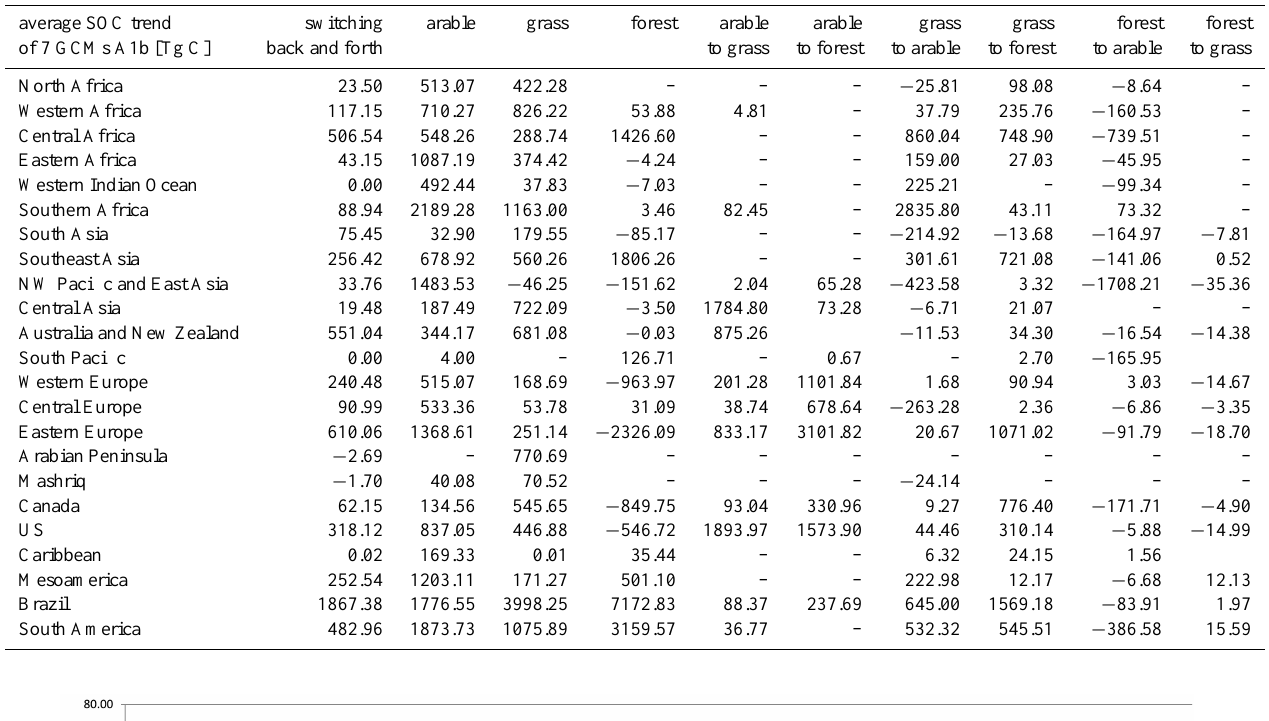
Table 6. Average SOC trend of seven GCMs per region and land use and land use change type. average SOC trend